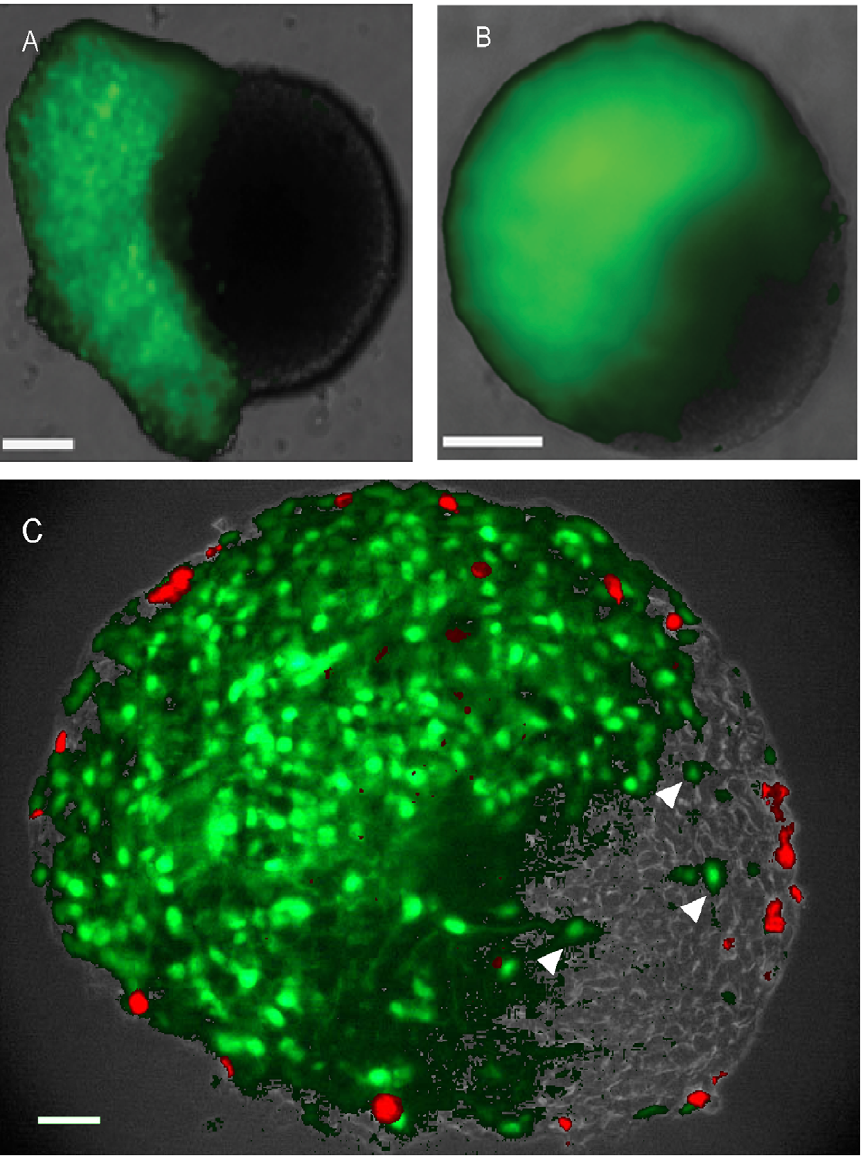
Figure 2. Cell migration and proliferation in chimeric mouse neurospheres. eGFP expressing neurosphere cells were centrifuged onto unlabeled intact neurospheres to produce chimeric neurospheres. Wholemount fluorescence images of living neurospheres taken (A) after 24 h and (B) after 96 h culture, showing green eGFP fluorescence: note that after 96 h the boundary between labeled and unlabeled cells has become diffuse. C, 8 m m equatorial section of typical chimeric neurosphere after 96 h culture, at the end of which the neurospheres had been incubated with 10 m M BrdU for 1 hour before fixation. Note that eGFP cells have migrated into the unlabeled half of the chimeric neurosphere (C, arrow heads), and that BrdU labelling (red) is restricted to the periphery of the chimeric neurosphere. Scale bars=100 m